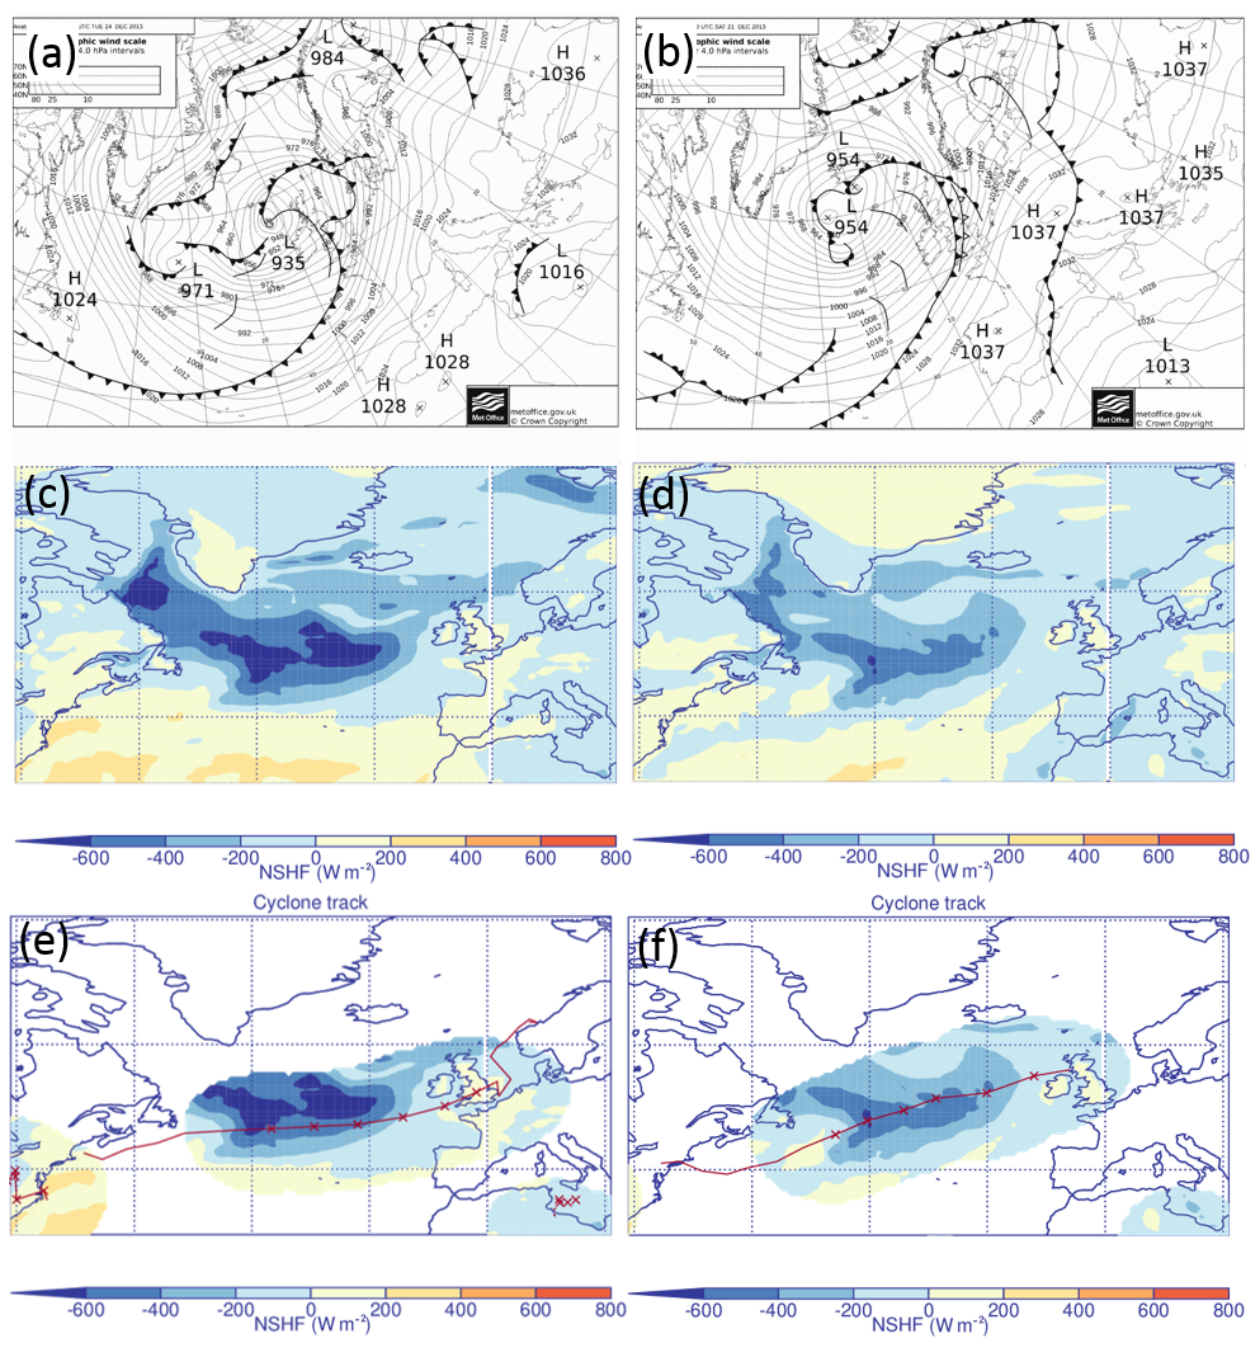
Figure 10. (a, b) UK Met Office synoptic analysis charts, (c, d) Q N (Wm − 2 ), and (e, f) cyclone mask overlaid with tracks for (a, c, e) 00:00UTC 24 December 2013 and (b, d, f) 00:00UTC 20 December 2013. Red crosses show the position of cyclones at the analysis time and 30h